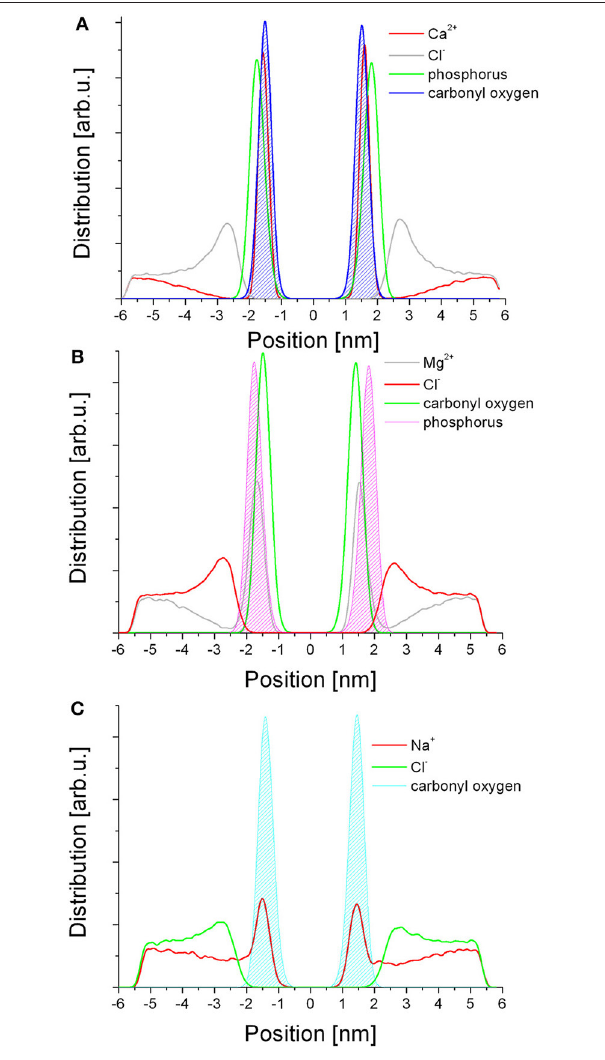
FIGURE 3 | Distribution of the ionic species in relation to selected lipid moieties in each respective simulation. (A) Ca 2 + ; (B) Mg 2 + ; (C) Na +